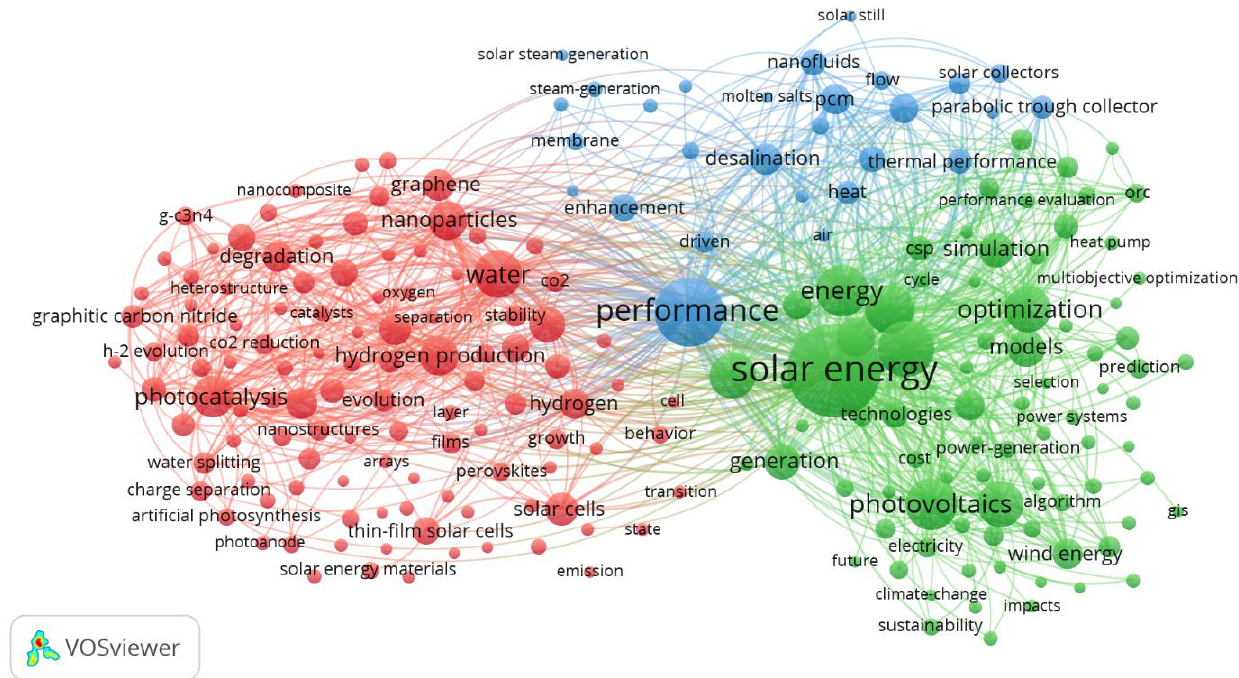
Figure 14. The 200 most common keywords network mapping for solar energy research during 2019–2020.